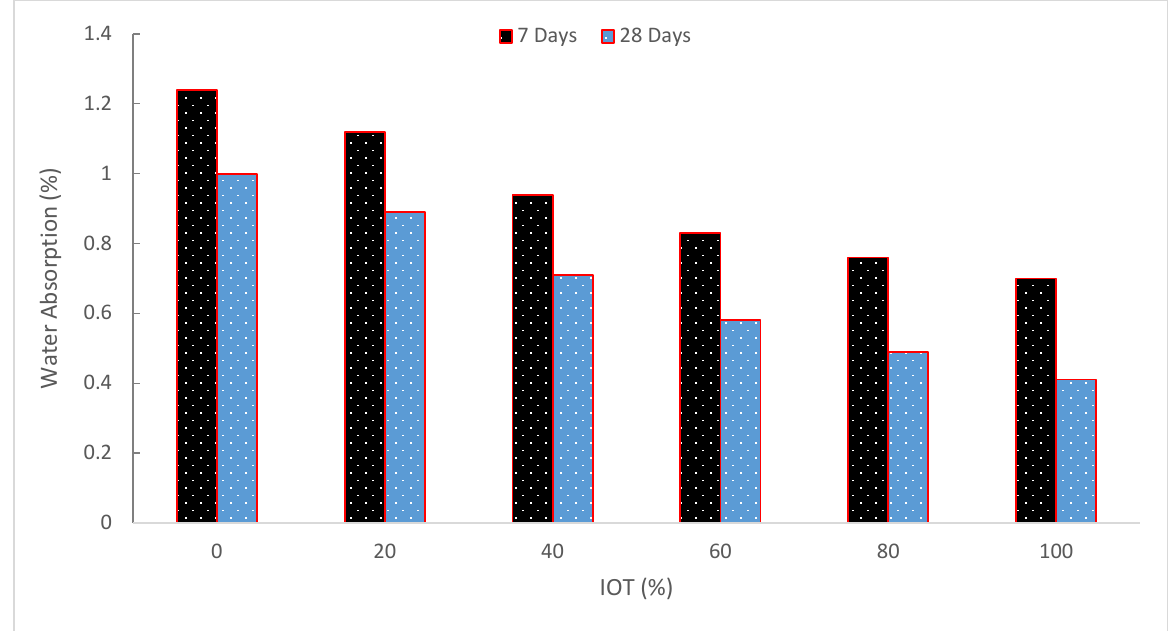
Figure 12. Water absorption (data source [47]).